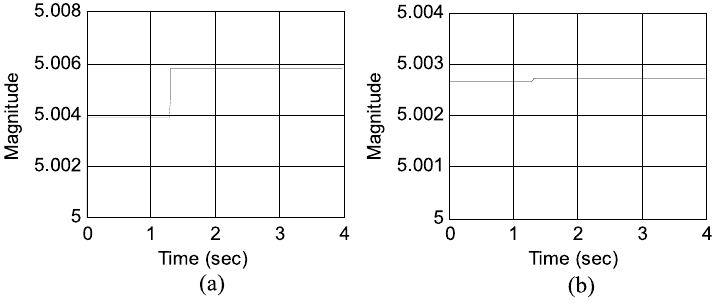
Fig. 3. (a) The adaptation parameter ˆ c 0 ( t ) (b) The adaptation parameter ˆ c 1 ( t )